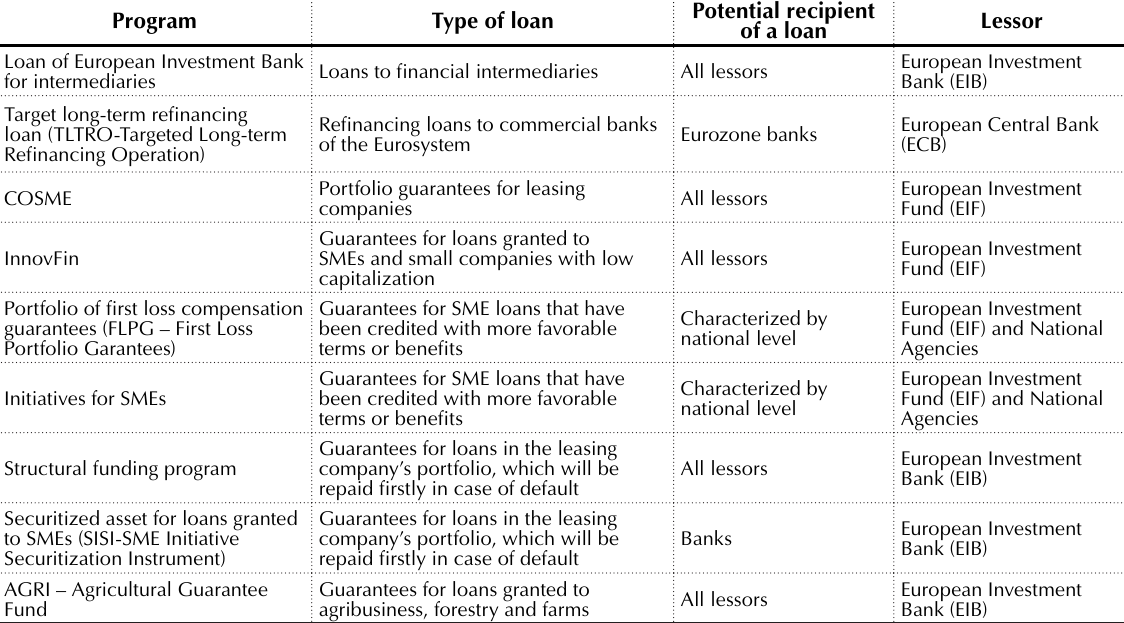
Table 3. Types of loans granted to support the leasing industry in the Eurozone Source: World Leasing Yearbook, 2017 (The Juncker Plan and other support for leasing in